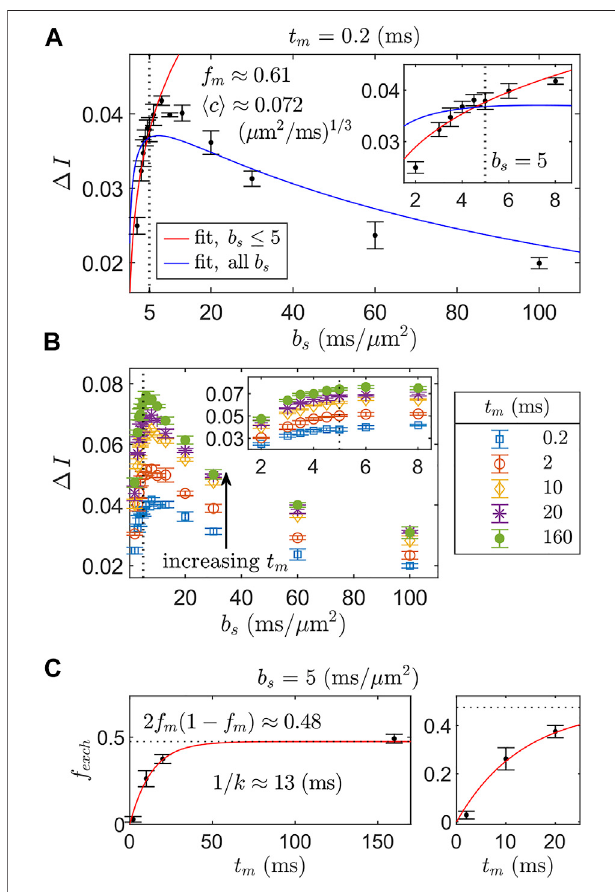
FIGURE 6 | REEDS-DE acquisition and fi tting scheme using SG-DEXSY data acquired on a fi xed spinal cord. (A) Δ I vs. b s curves for step 1 of REEDS- DE ( Figure 3A ). Δ I was measured at b s = (2, 3, 3.5, 4, 4.5, 5, 6, 8, 10, 13, 20, 30, 60, 100) ms/ μ m 2 with t m = 0.2 ms. Error bars = ± 1 SD from three technical replicates. Two fi ts to Eq. 18 are compared: one (red line) using the fi rst six b μ m 2 (dotted line),whilst1.23 ℓ ≤ ℓ ≤ 1.6 ℓ s valuesupto b s =5 ms/ g d g , and theother(blueline)using all b s values.Thetruncated fi tevaluatedoverthe truncatedregionhasRSS=1.3×10 – 4 vs.5.8×10 – 4 forthefull fi tandyields f m ≈ 0.61, 〈 c 〉 (cid:1) 0 . 072 ( μ m 2 /ms ) 1/3 . The data are best fi t near ℓ ≳ ℓ d g . An initial guessof f m =0.2and 〈 c 〉 (cid:1) 1 × 10 − 4 ( μ m 2 /ms ) 1/3 wasprovided.Insetshows zoomed plot. (B) Δ I vs. b s curves acquired at t m = [0.2, 2, 10, 20, 160] ms for step 2 of REEDS-DE ( Figure 3B ). Error bars = ± 1 SD from three technical replicates.Insetshowszoomed plot. (C) f exch calculatedfrompointsin (B) ata fi xed b μ m 2 using Eq. 20 . The t s = 5 ms/ m = 0.2 ms point was used for the correction term, Δ I ( t m = 0). Values were fi t to Eq. 9 , yielding k = 75 s − 1 and 1/ k ≈ 13 ms (RSS = 0.013). An initial guess of k = 70 s − 1 was provided. The measured steady-state exchange fraction, f exch ( t m = 160 ms) = 0.49 ± 0.03, agrees with 2 f m (1 − f m ) ≈ 0.48. Zoomed plot shown to the right.